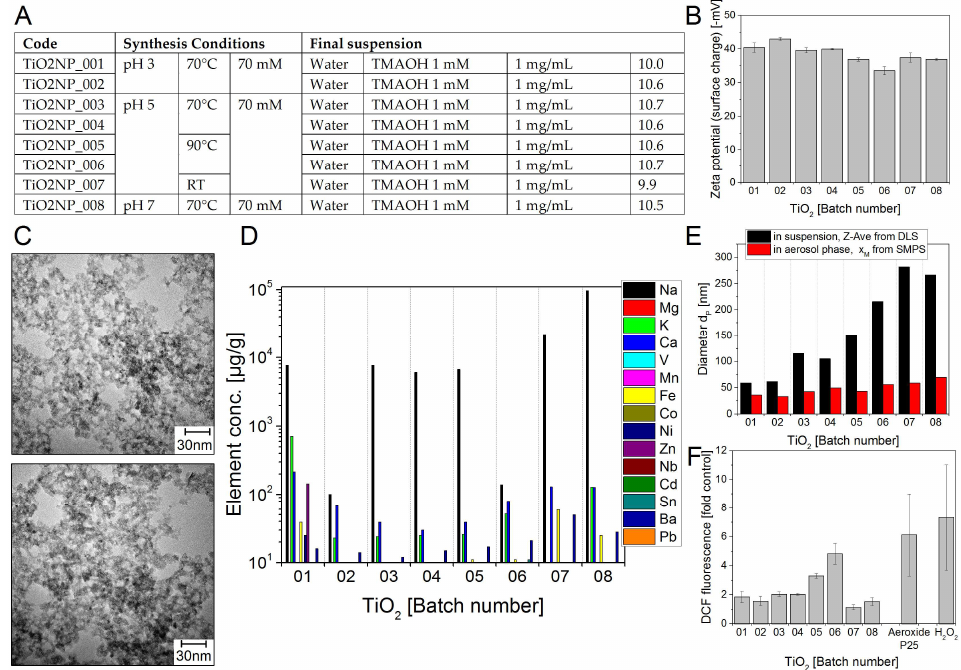
Figure 4. Titanium dioxide NM batches TiO 2 NP01–08 ( A ) Production parameters for sol-gel synthesized titania nanoparticles; ( B ) Zeta potential representing the surface charge in –mV at pH ~10; ( C ) Representative TEM images ( D ) Selected impurities present in the different TiO 2 NM batches. The mass concentrations of elements above detection limit are shown. The data represent the mean of two assays; ( E ) Particle diameters d P in nm: Z-Average of d P determined in aqueous suspension using DLS (black bars) and modal value x M of the number size distribution in the aerosol phase measured by SMPS (red bars); ( F ) The test NMs were delivered as suspensions of 1 mg/mL in water. The graph shows the DCF fluorescence induced by the different batches at 400 µ g/mL relative to a sample without NMs (control). 400 µ g/mL commercial TiO 2 (Aeroxide ® P25, Evonik, Essen, Germany) and 0.3 µ M H 2 O 2 was used as positive controls. The data represent mean values of 2 independent experiments with three replicates ± s.e.m.